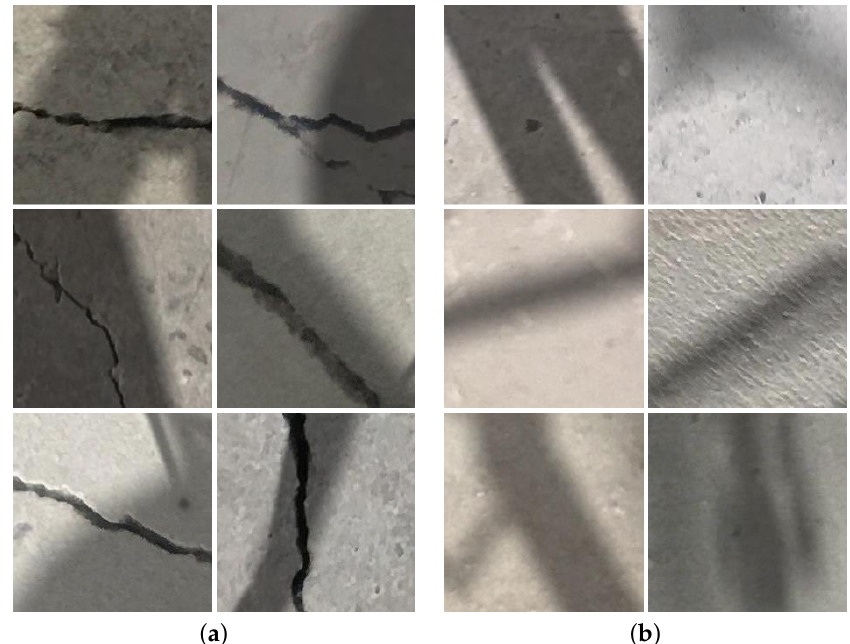
Figure 2. Sample images from the testing dataset used for the concrete-crack detection. Concrete images with and without cracks are displayed in the parts ( a , b ), respectively.